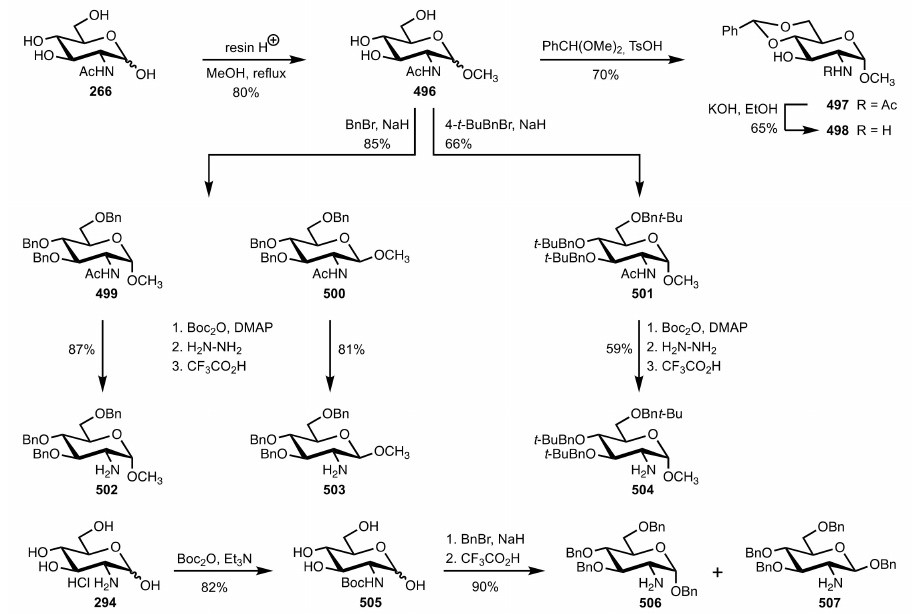
Scheme 128. The synthesis of the D -glucosamine glycosides